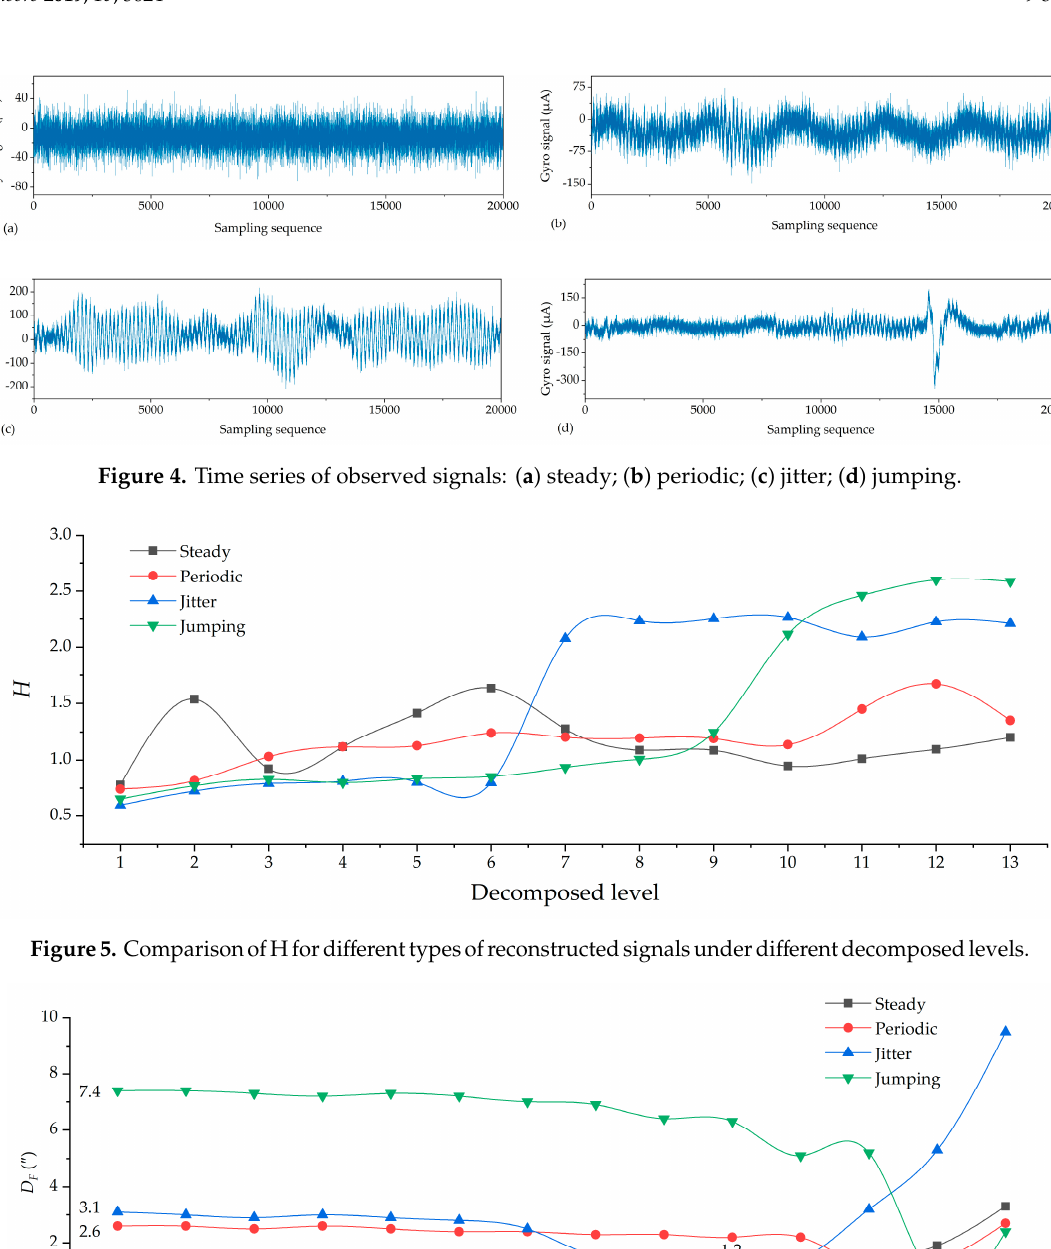
Figure 6. Comparison of D F for different types of reconstructed signals under different decomposed levels.